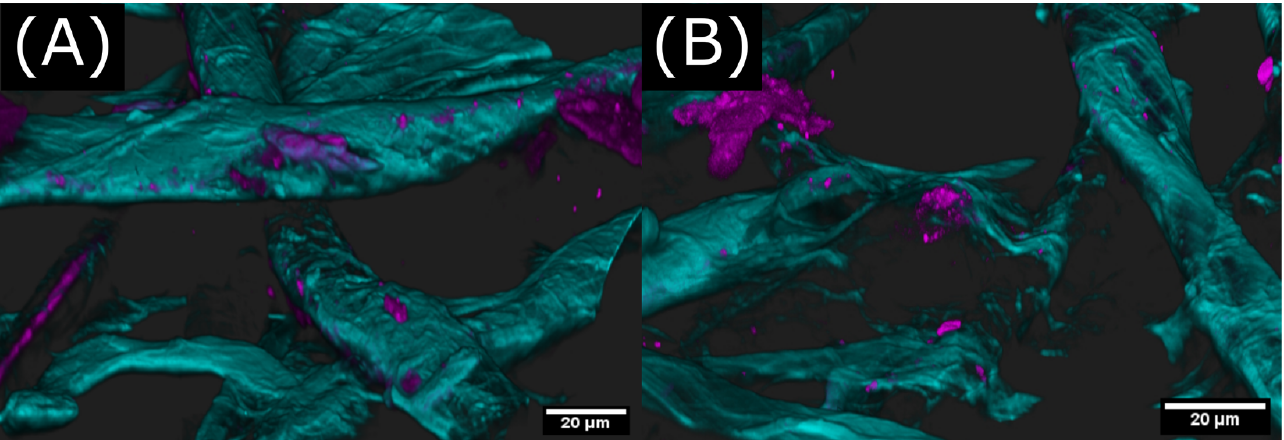
Figure 11. Magnified CLSM image via z-stack acquisition: Here, labeled keto-HPC accumulates on the fiber surface and also penetrates through the fiber wall ( A ); in addition, polymer accumulations of keto-HPC are located within fiber–fiber intersections and welding fibers together ( B ).